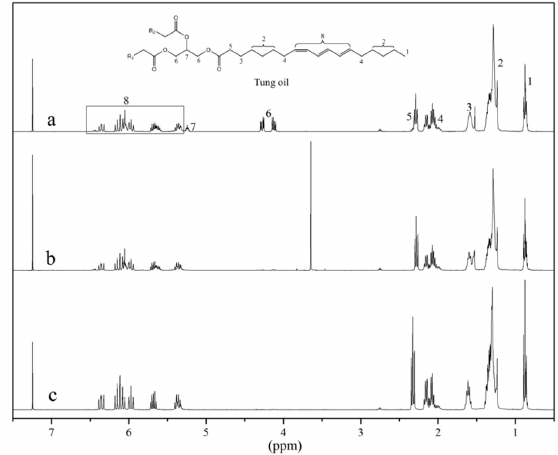
Figure 2. 1 H NMR spectra of ( a ) tung oil, ( b ) tung oil methyl esters, and ( c ) α -eleostearic acid.